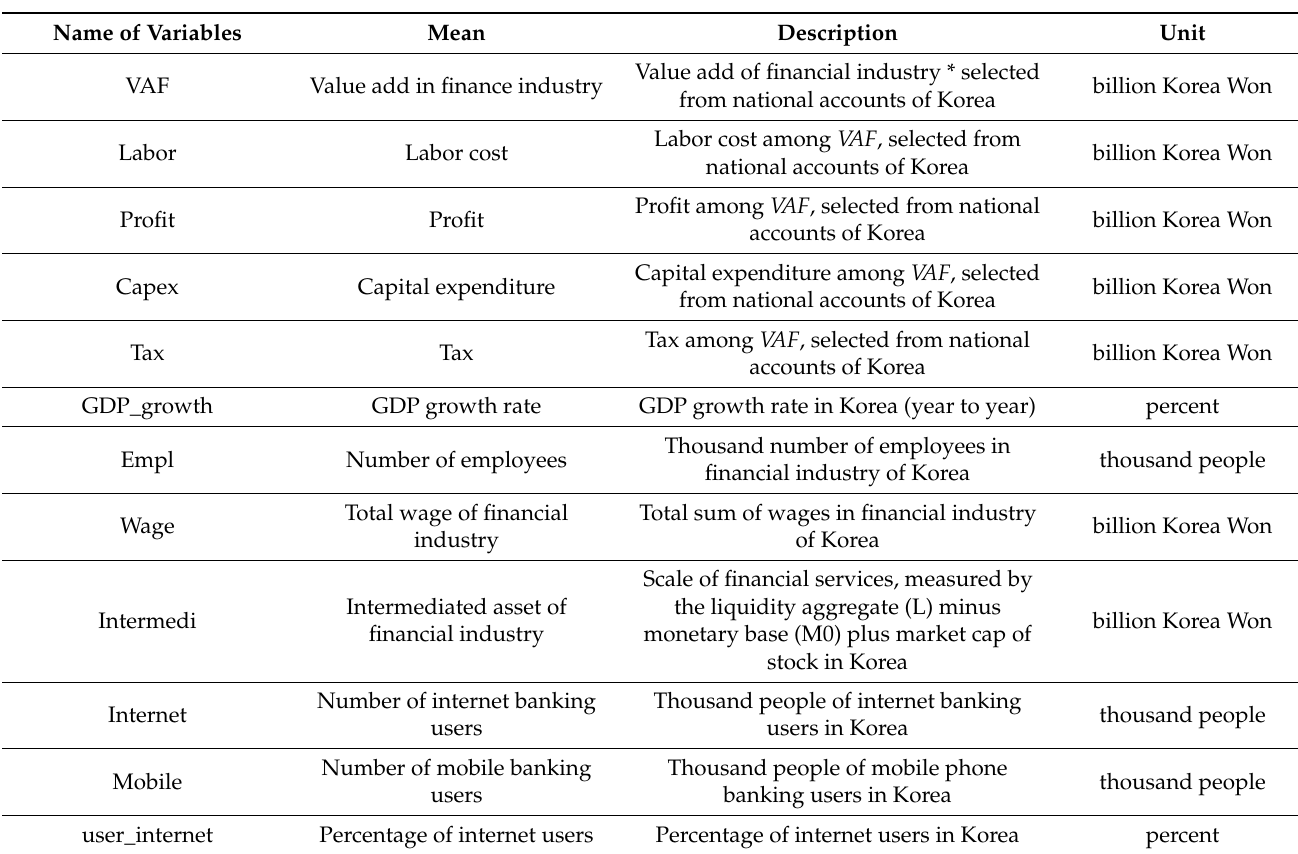
Table 1. Variable descriptions.